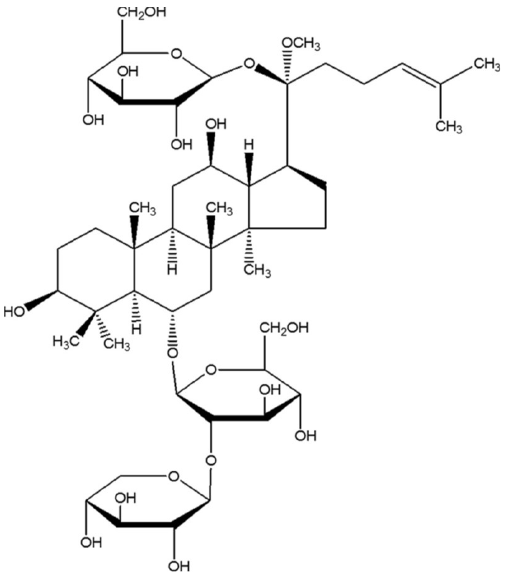
Figure 1. The chemical structure of Notoginsenoside R1 (NGR1).